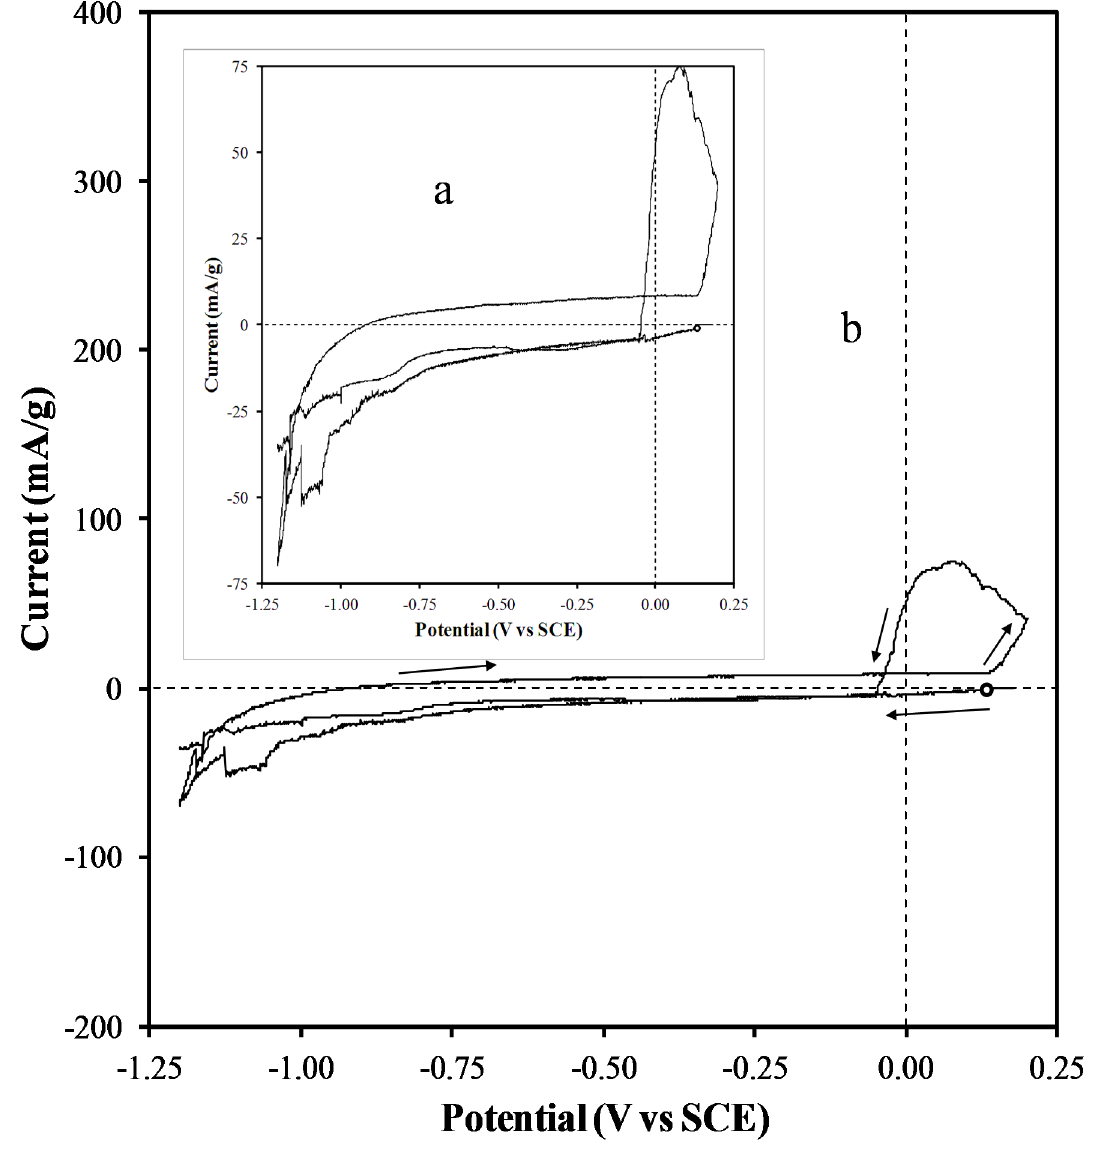
Figure 2. ( a ) Voltammogram of chicken manure biochar produced at 400 °C; ( b ) is that of particles of Terra Preta soils taken from Hata Hara